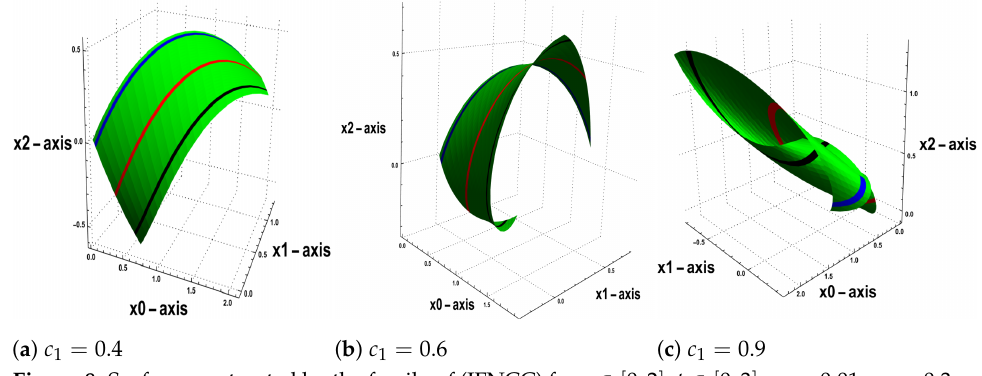
Figure 8. Surface constructed by the family of (IFNCC) for s ∈ [ 0,2 ] , t ∈ [ 0,3 ] , c 2 = 0.01, µ 0 =